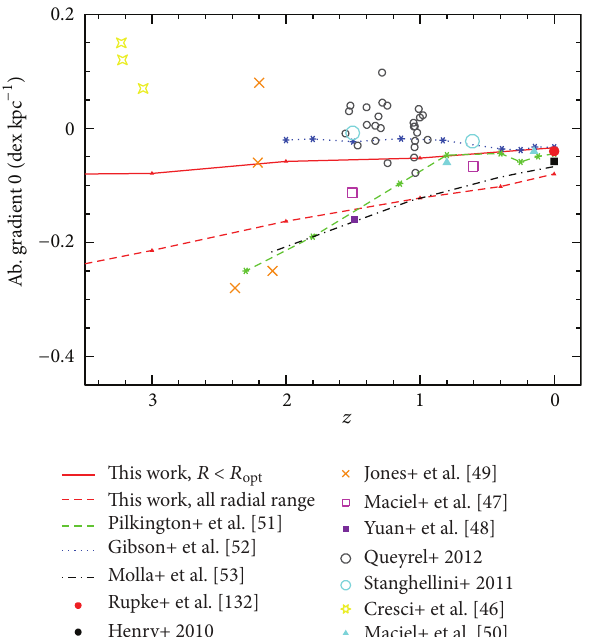
Figure 18: Evolution of the radial gradient of oxygen abundance for a MWG-like galaxy (number 5 from Table 1) along the redshift compared with observations. Dots are data from Maciel et al. [136], Rupke et al. [137], Stanghellini et al. [138], Cresci et al. [58], Yuan et al. [59], Queyrel et al. [60], Jones et al. [61], and Maciel et al. [139] as labeled, while lines are simulations from Pilkington et al. [140], Gibsonetal.[141],andouroldmodelresultsforMWG[142],asgiven in the plot. For this work we have two lines, one obtained by using all the radial range and the other only for disk within the optical radius, that are shown by the short-dashed and solid lines,